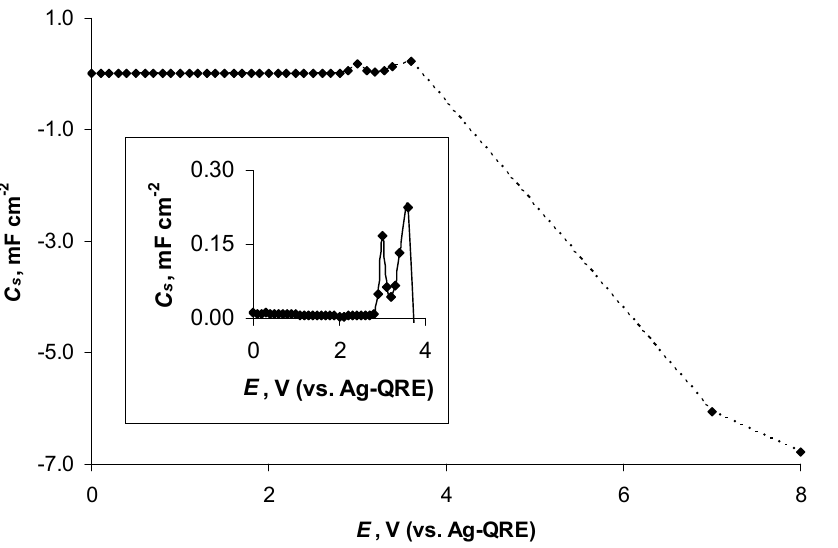
Figure 6. Series capacitance ( C s ) vs. Al-electrode-potential ( E ) relationship at the electrochemical- impedance-spectroscopy modulation frequency of 0.10 Hz.